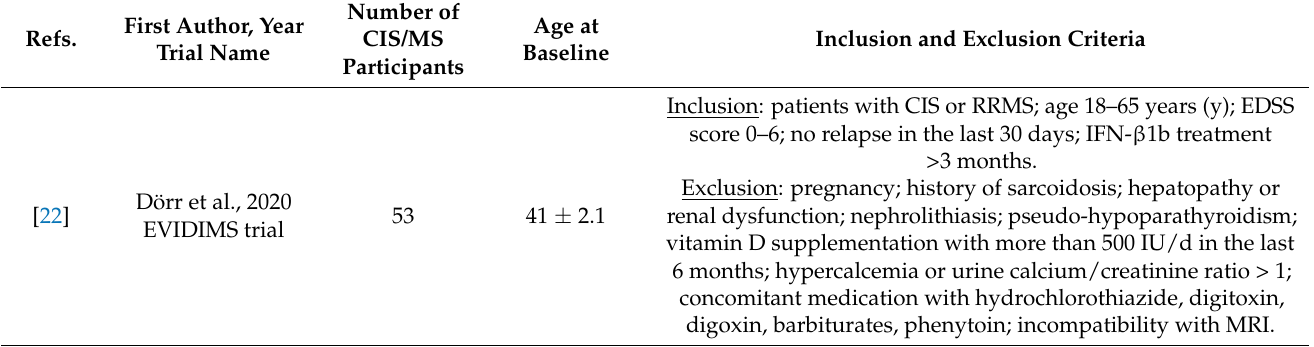
Table 3. Characteristics of participants within the studies included in the systematic